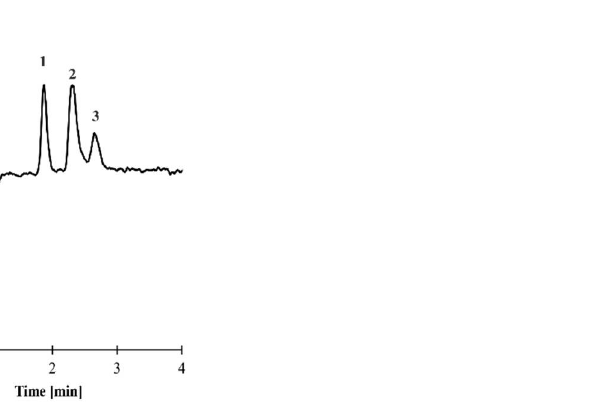
Figure 3. A representative total ion chromatogram of sample 13.2 prepared according to the procedure described in Section 4.5. Chromatographic conditions were as described in Section 4.5. Peaks: 1-lactic acid, 2-citric acid, 3-succinic acid (for assay details, see Supplementary Materials). Table 3. The concentration (mM) of organic acids: lactic, citric, and succinic acids in cell-free supernatants of Lactobacillus strains. The results are presented as the means of three experiments. Lactobacillus